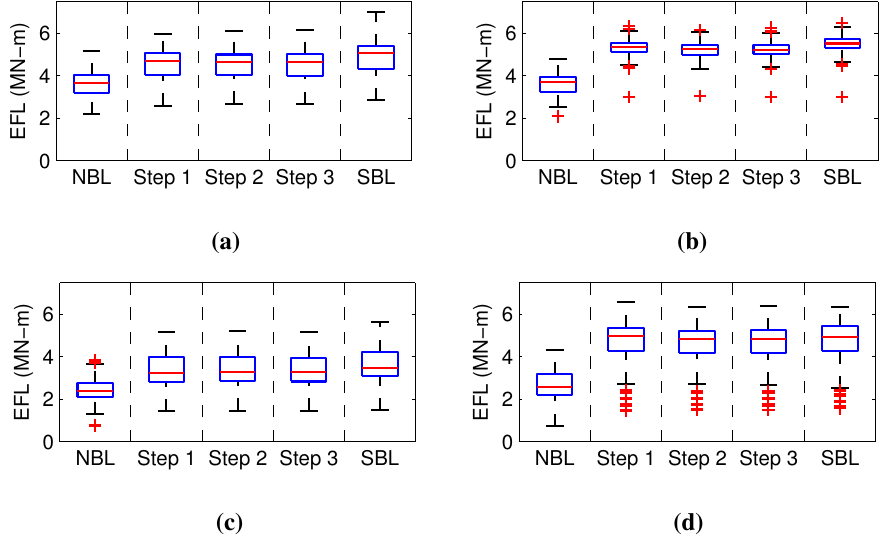
Figure 25. EFL statistics for OoPBM from 2200 wind fields (SBL versus baseline NBL and < 0 modified cases). ( a ) z α